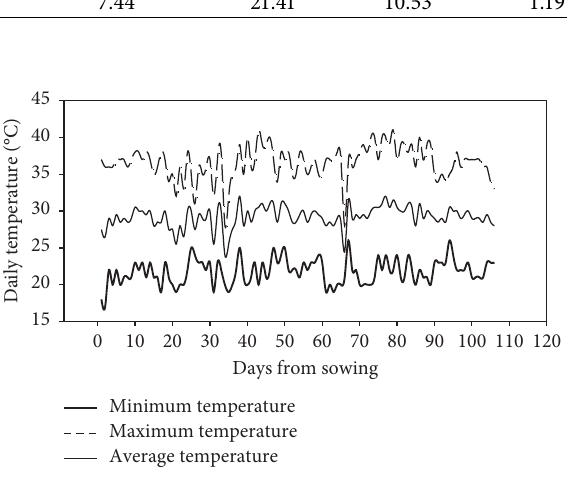
Figure 1: Daily minimum, maximum, and average temperatures during the crop growth Table 2: Mean squares of ANOVA for evaluation of drought stress tolerance based on selection indices in haricot bean varieties exposed to drought stress at different growth stages.